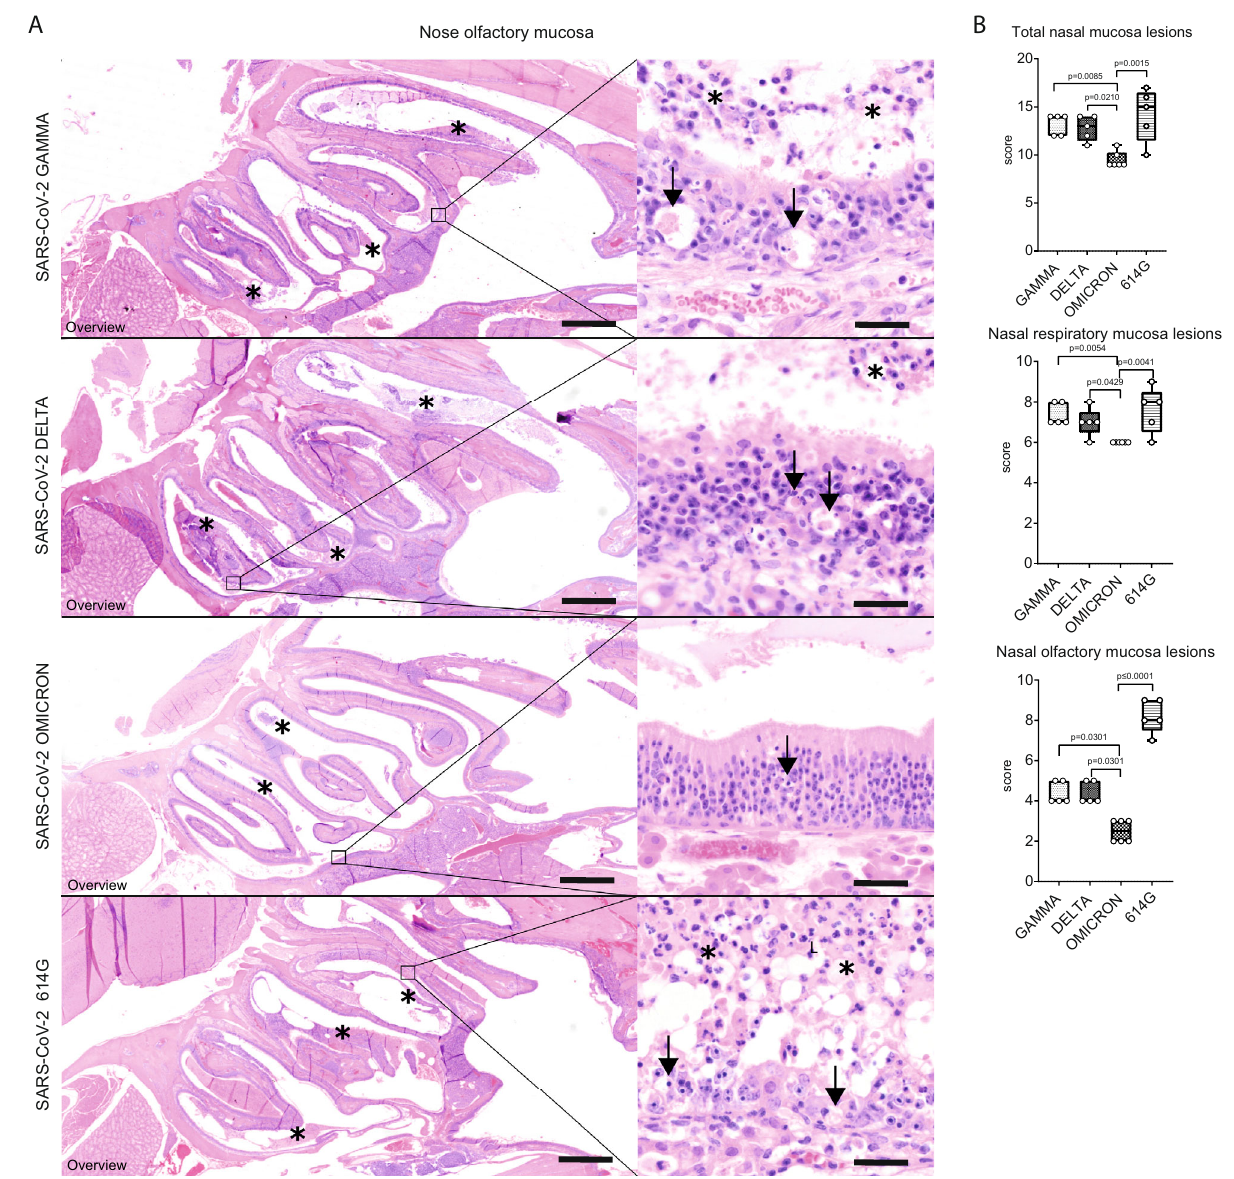
Fig. 2 Decreased pathogenicity of VOC Omicron for nasal olfactory mucosa compared to other SARS-CoV-2 strains. A Representative images showing an overview of the caudal nasal turbinates (left panel) and high magni fi cation of the olfactory mucosa (right panel) of hamsters infected with VOCs Gamma, Delta, Omicron or 614 G strain. Olfactory mucosa in VOCs Gamma and Delta or 614G infected hamsters showed the most striking histopathological changes. Lesions were mainly characterized by disorganization, cell death (arrows) and cell sloughing, associated with intraluminal exudate composed of proteinaceous fl uid, cell debris and degenerated neutrophils/heterophils (asterisks). Olfactory mucosa in VOC Omicron infected hamsters was largely intact and only occasional cell death was observed (arrow). Scale bars = 1 mm (overviews) and 50 µ m (high magni fi cations). Hematoxylin and eosin stain. B Semi-quantitative analysis of nasal turbinates histopathology revealed signi fi cantly lower values in the overall score as well as the separate scores for respiratory and olfactory mucosa in VOC Omicron infected hamsters. Data are shown as box and whisker plots. The bounds of the box plot indicate the 25th and 75th percentiles, the bar indicates medians, and the whiskers indicate minima and maxima. Data were tested by two- tailed Mann – Whitney- U tests followed by Benjamini – Hochberg correction. A p -value of ≤ 0.05 was chosen as the cut-off for statistical signi fi cance. N = 5 animals/group for VOCs Gamma and Delta and 6 animals/group for VOC Omicron and 614 G. For quanti fi cation, one entire longitudinal section of the nasal turbinates was evaluated per animal. Source data are provided as a Source Data fi